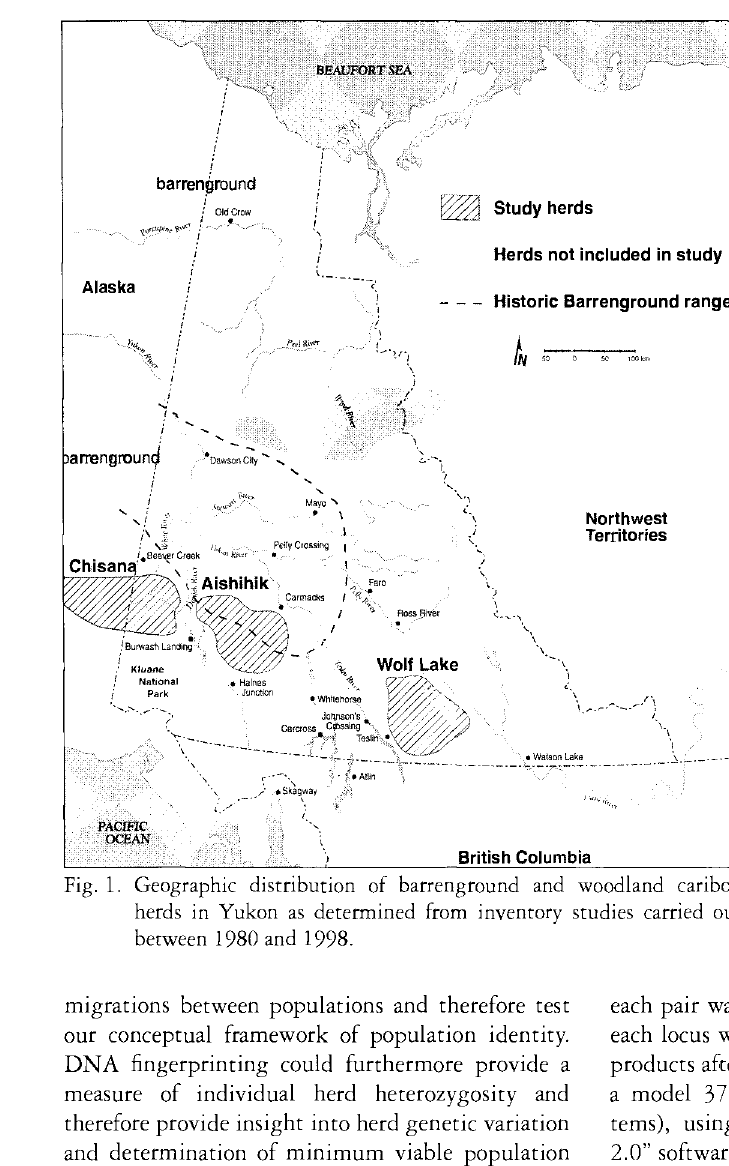
Fig. 1. Geographic distribution of barrenground and woodland caribou herds in Yukon as determined from inventory studies carried out between 1980 and